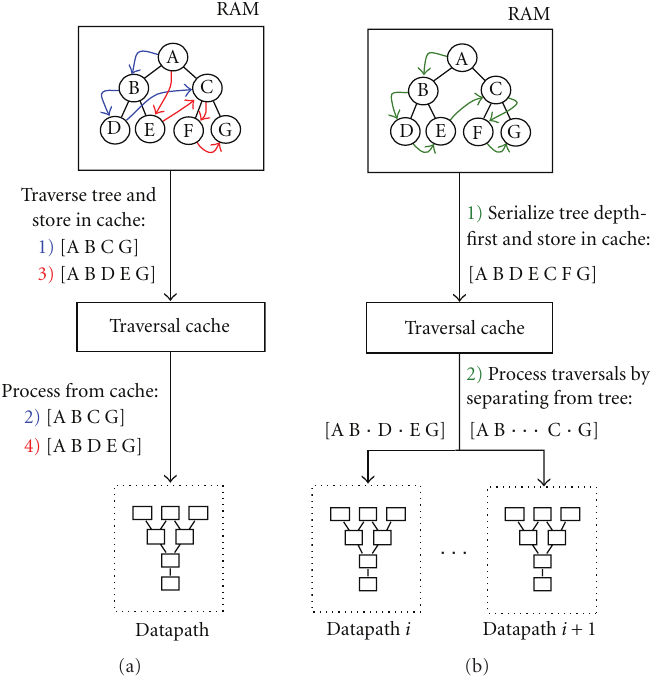
Figure 3: (a) Despite large amounts of similarity, nonrepeated traversals result in a 100% miss rate using the general framework, transferring a new traversal each time. (b) Extensions to the framework exploit the similarity between traversals by storing the entire tree in the cache and separating out individual traversals while streaming, also enabling datapath replication. (Elements excluded from separated traversals are shown as ( ·